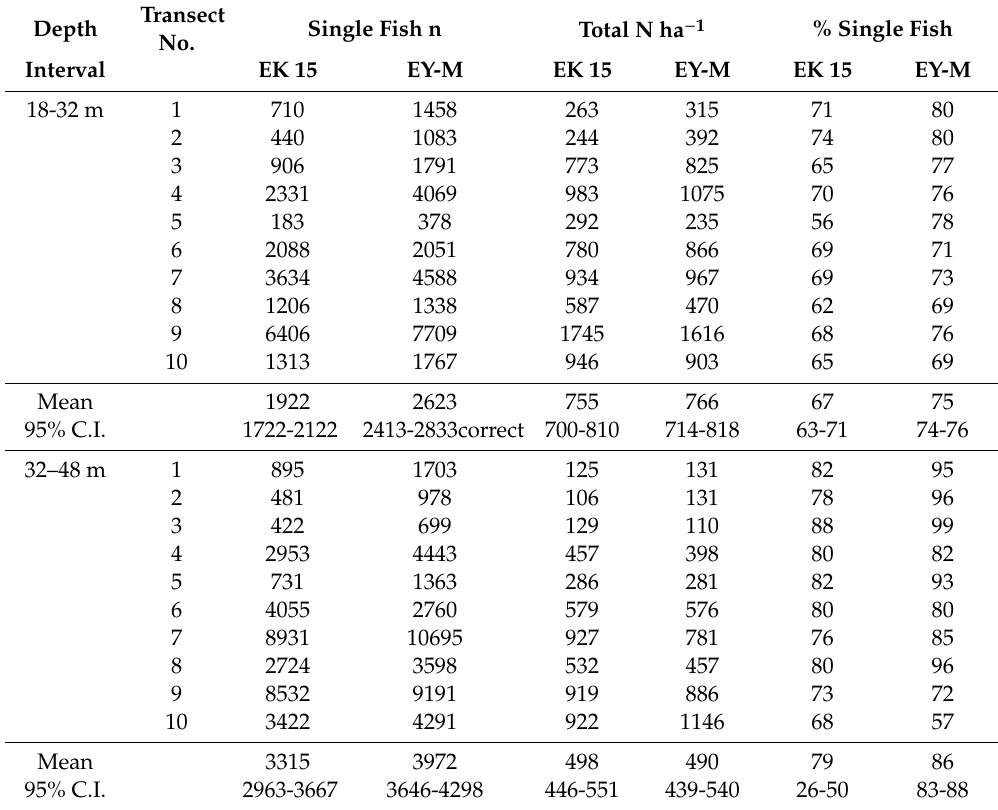
Table 1. Single fish density (TS ≥ 56 dB), total density and proportion of single fish recorded with Simrad EY-M and Simrad EK15 at two depths along 10 transects on 27 May 2016 in Lake